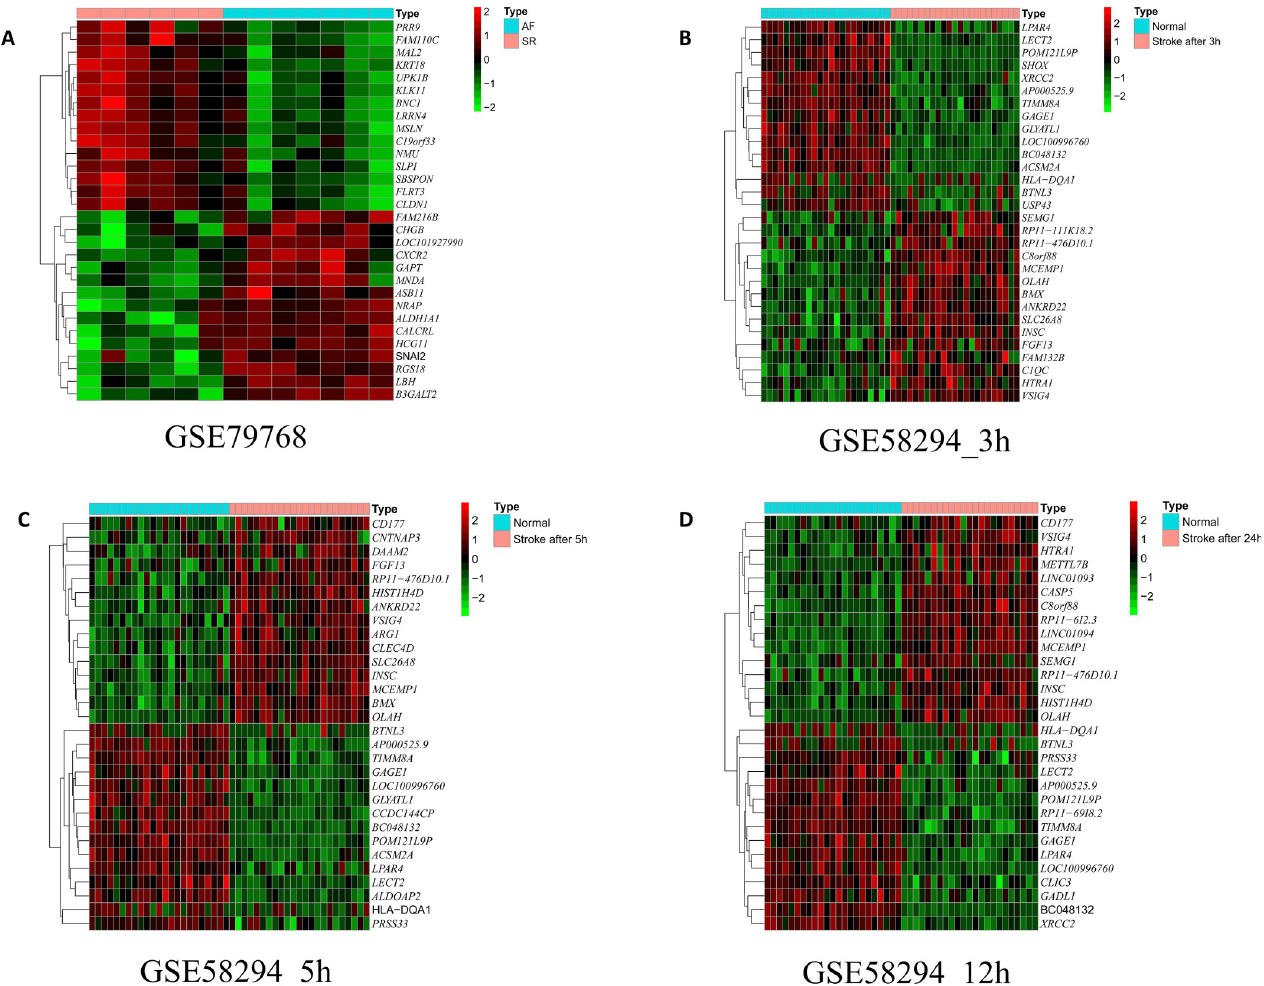
Fig 2. Identification of differentially expressed genes. Heatmap of the top 30 differentially expressed genes based on GSE79768 (A), and at < 3 h (B), 5 h (C), 24 h (D) after stroke in GSE58294. The color intensity (from red to green) suggests the higher to lower expression.